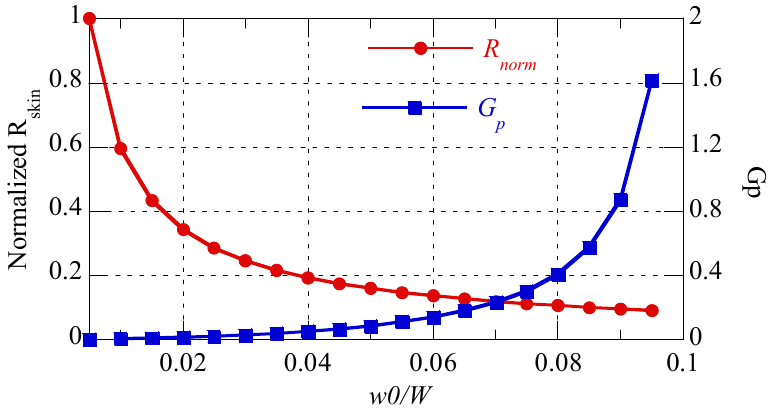
Figure 5. Normalized skin resistance ( R norm ) for w 0/ W = 0.005 and proximity factor, G p , according to w 0 /W .